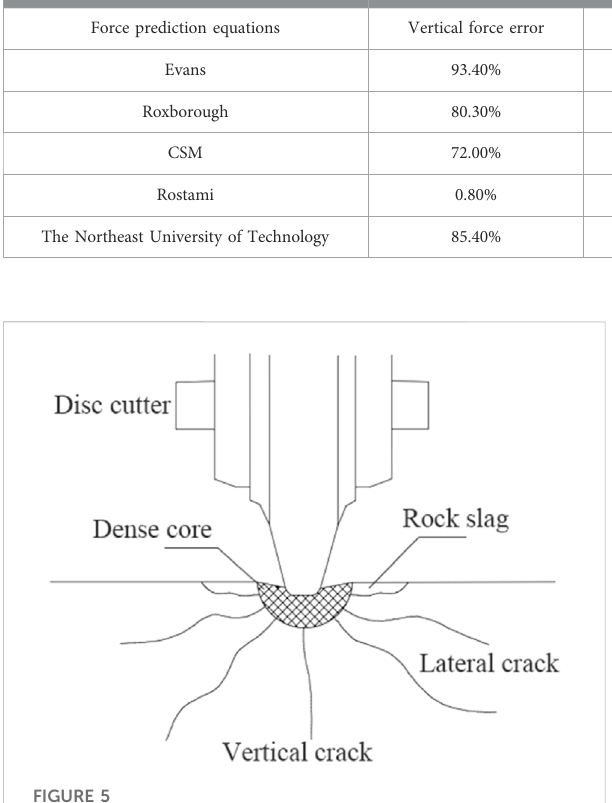
FIGURE 5 Schematic diagram of cracks developed in the rock mass during the rock-breaking process of disc cutter.